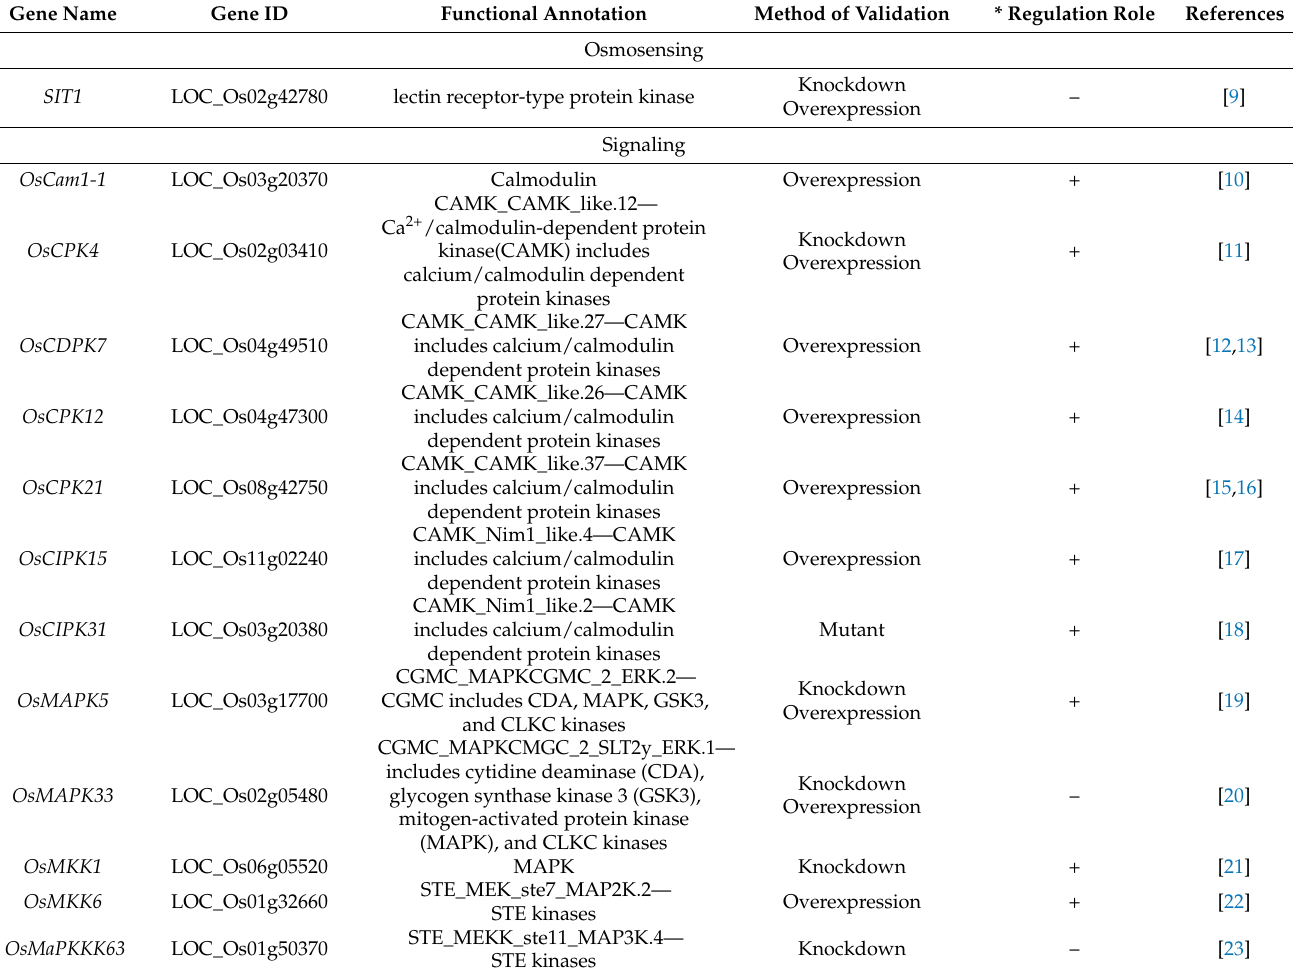
Table 1. List of functionally validated candidate genes involved from sensing to development of salt tolerance adaptive mechanisms in